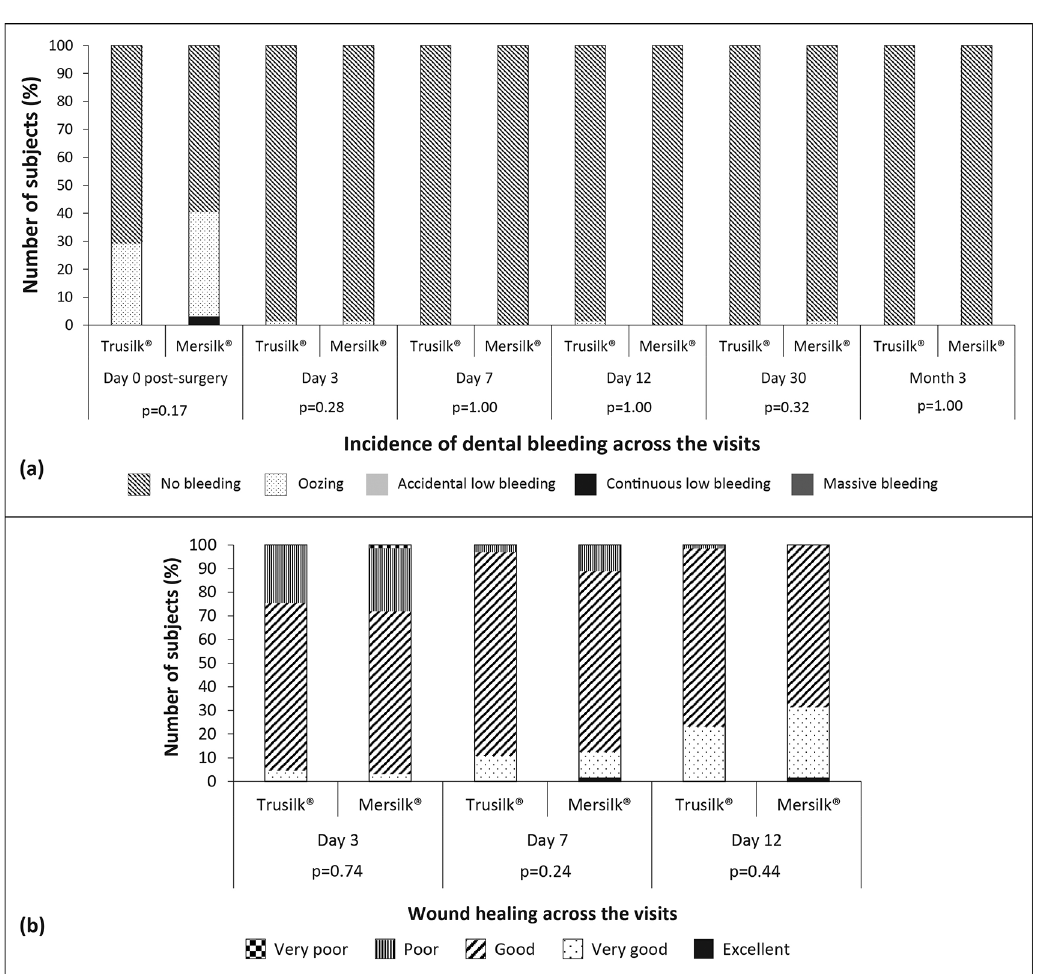
Figure 4. Dental bleeding (a) and wound healing (b) in Trusilk ® (n=65) and Mersilk ® (n=64)